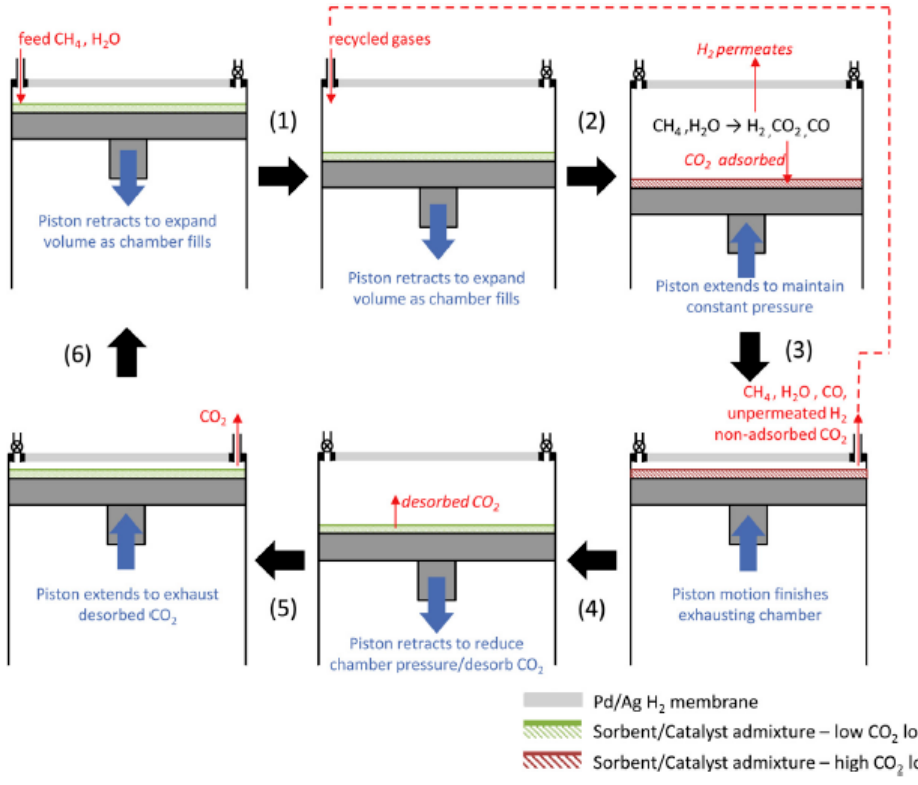
Figure 4. Schematic representation of the CHAMP-SORB reactor for methane SR. Reprinted from [28] with permission from Elsevier.